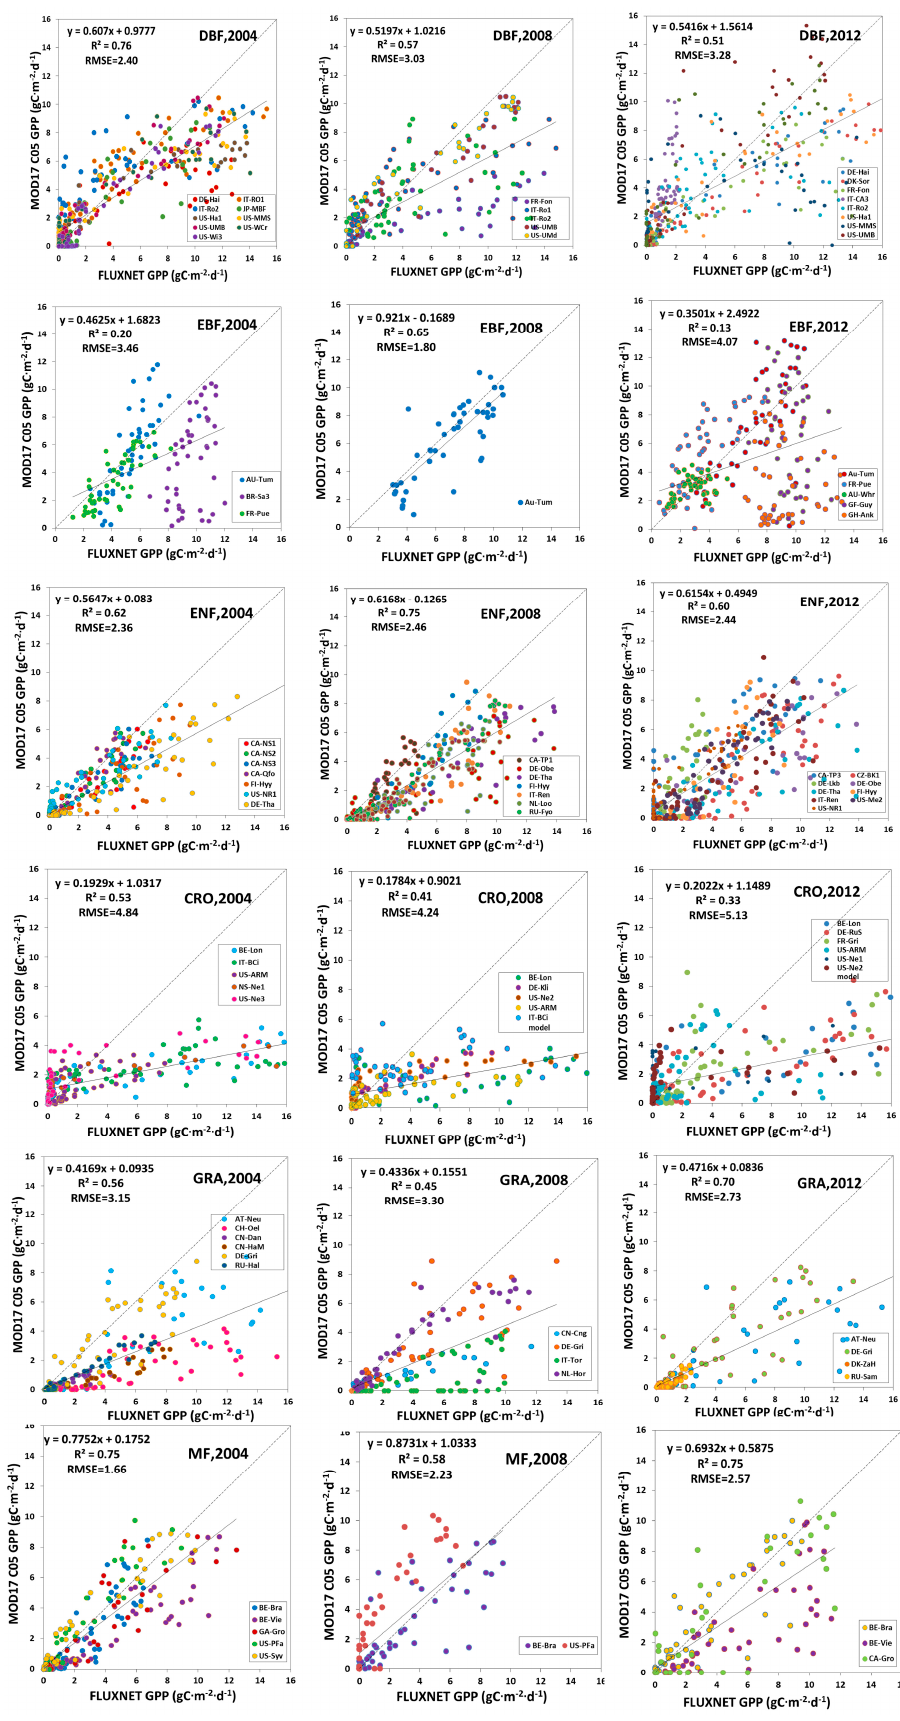
Figure 10. MODIS C05 GPP validation against FLUXNET GPP.